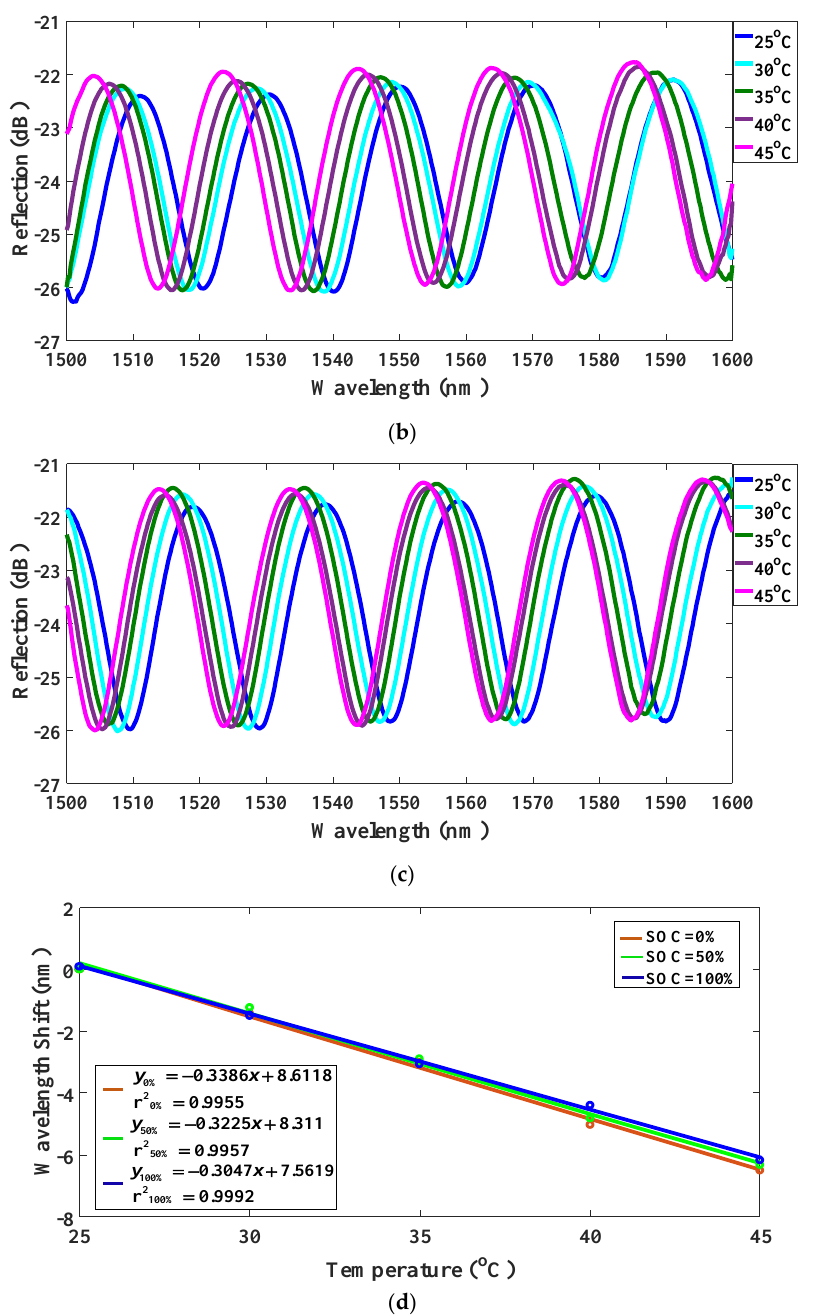
Figure 8. Experiment results: ( a ) the interference spectra measurement of positive electrolyte with 0% SOC under 25 – 45 °C; ( b ) the interference spectra measurement of positive electrolyte with 50% SOC under 25 – 45 °C; ( c ) the interferences spectra measurement of positive electrolyte with 100% SOC under 25 – 45 °C; ( d ) the co-plotting of wavelength shift-temperature results presented in ( a ), ( b ), and ( c ).